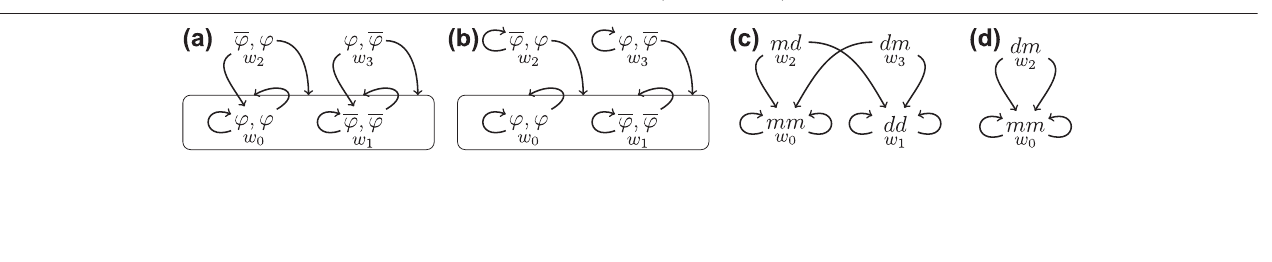
Frontiers in Communication |